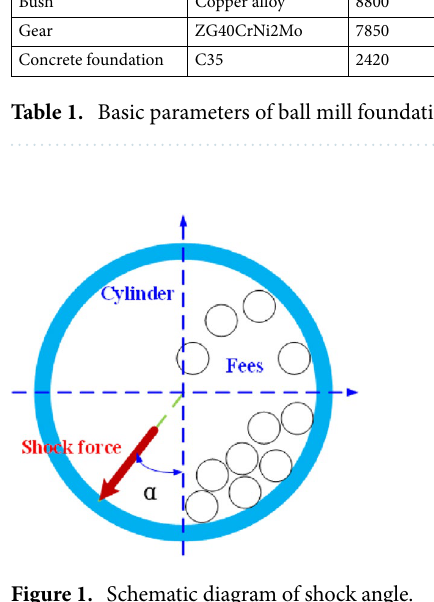
Figure 1. Schematic diagram of shock